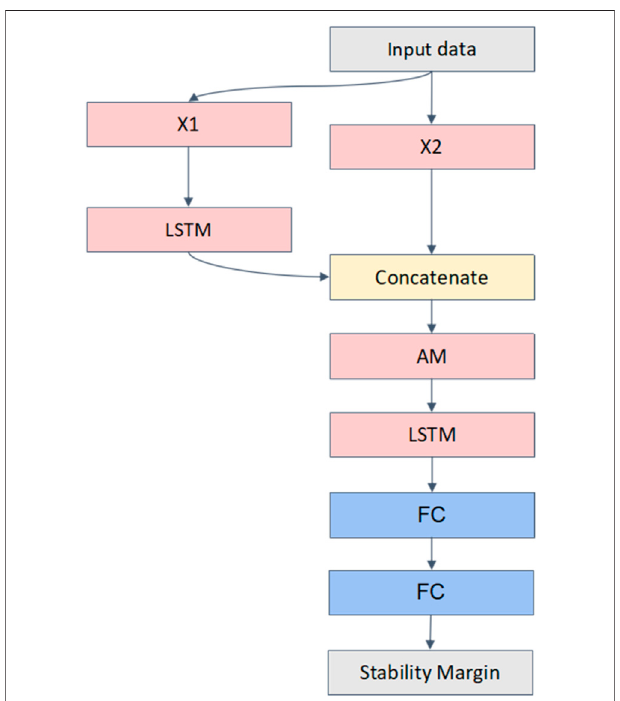
FIGURE 3 | Model structure based on LSTM network and